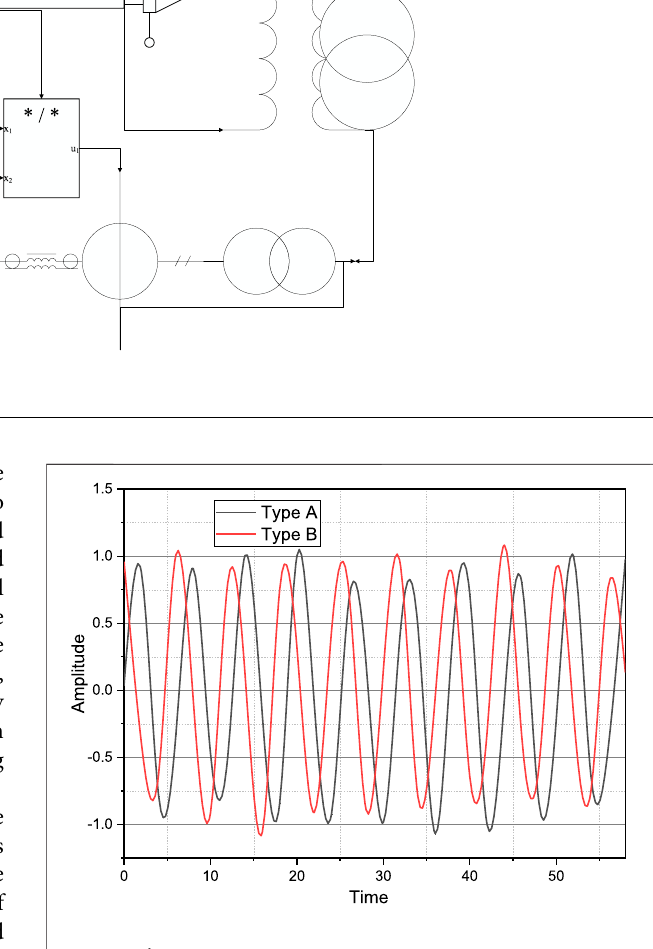
FIGURE 3 | Time-domain signal